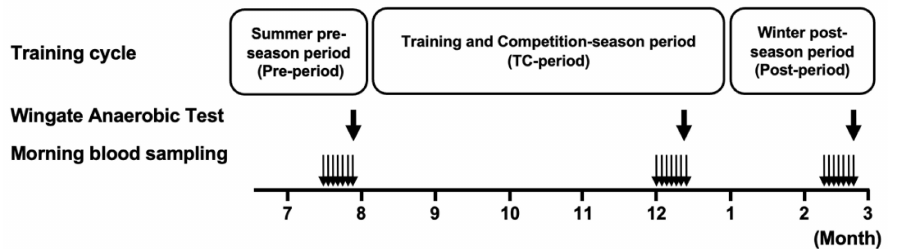
Figure 1. Schematic overview of the experimental design. The bold arrows indicate the time of the 40 s Wingate test and metabolic measurement during each period. The narrow arrows indicate blood lactate sampling at the time of waking each day of the